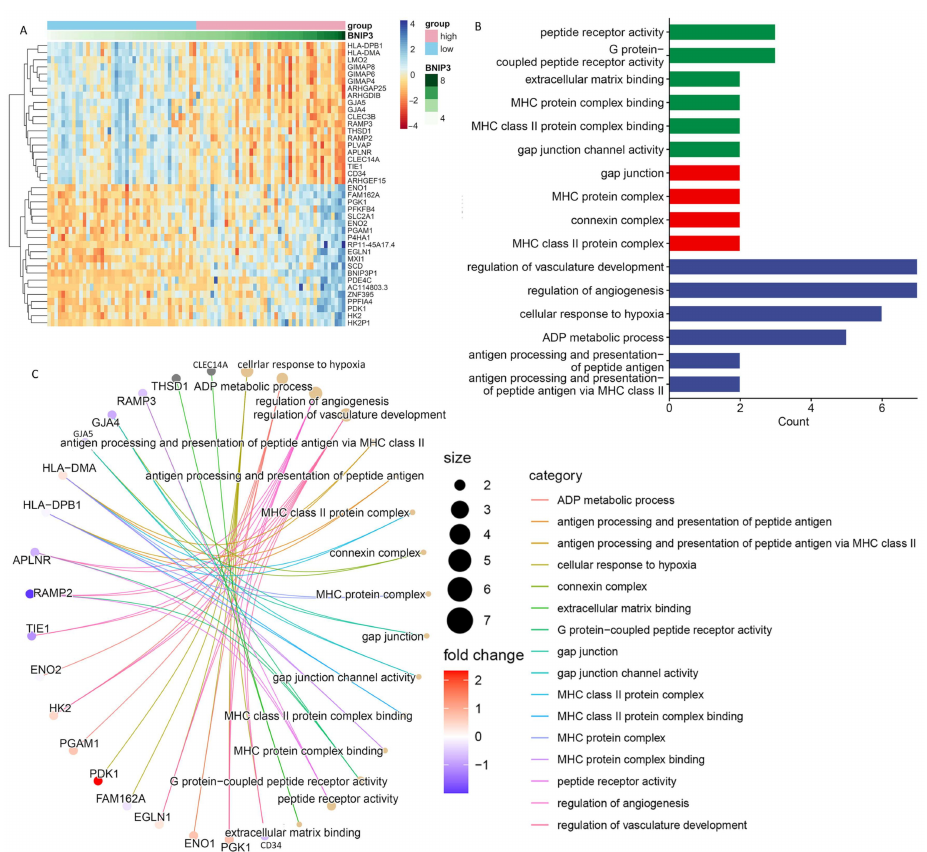
Figure 9. Pathway enrichment analysis of the genes most strongly associated with BNIP3. ( A ) Heatmap showing the 20 genes with the strongest positive or negative correlations with BNIP3 expression. ( B , C ) Pathway enrichment analysis showing the enrichment of genes in different